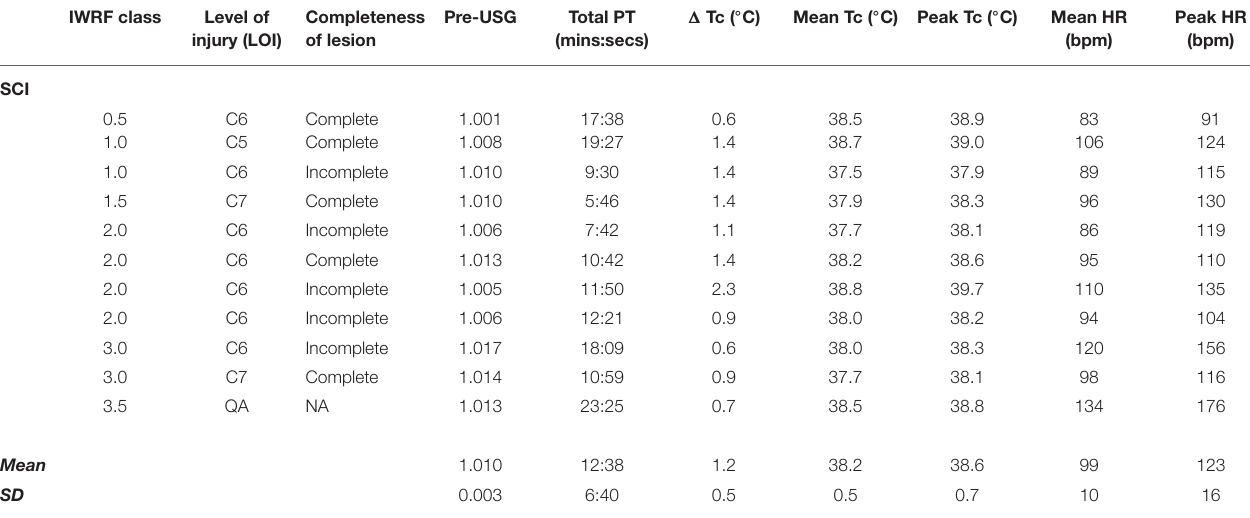
TABLE 1 | Descriptive characteristics of the male participants (mean ± SD).